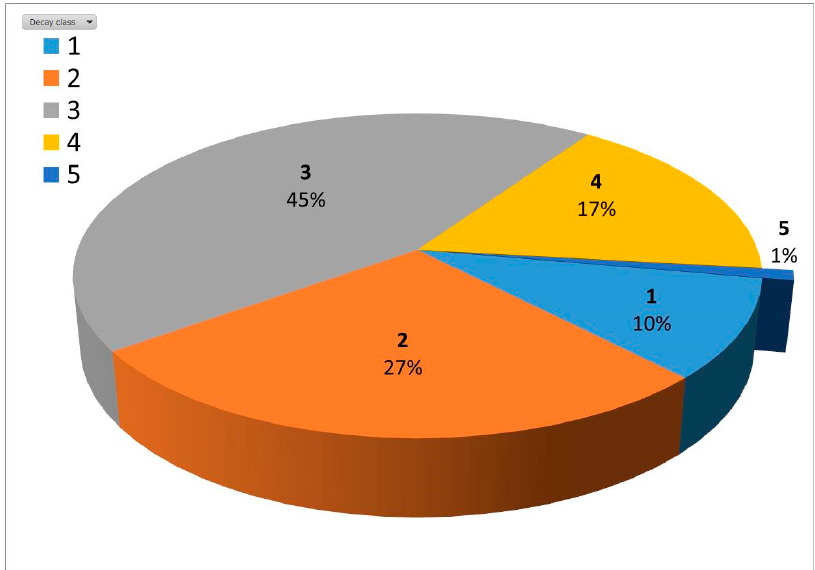
Figure 7. Overall distribution of decay classes of dead standing and lying wood in the restored open-cast lignite mining areas.